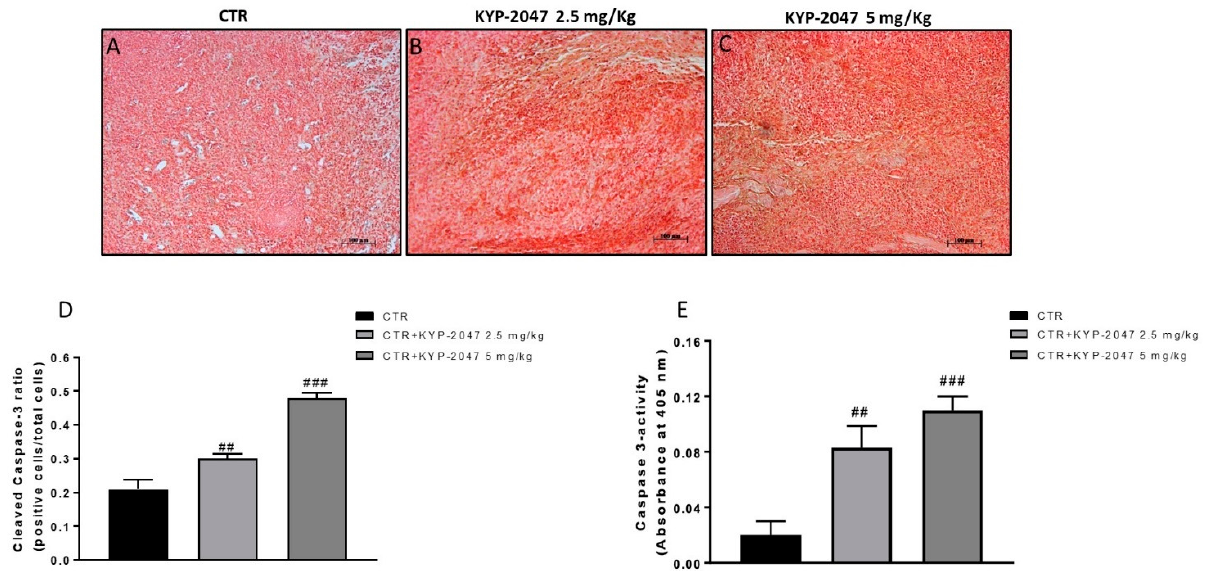
Figure 6. Effect of KYP-2047 on caspase-3 expression. Immunohistochemistry assay revealed an increase of cleaved-caspase-3 expression following KYP-2047 treatment at doses of 2.5 mg/kg and 5 mg/kg compared to control group ( A – C ). Sections were observed and photographed at 10× magnification. Additionally, the data for caspase-3 were confirmed also by a colorimetric assay kit as shown in the panel E. Data are representative of at least three independent experiments. ( D ) ## p < 0.01 vs. CTR; ### p < 0.001 vs. CTR; ( E ) ## p <0.01 vs. CTR; ### p < 0.001 vs. CTR.